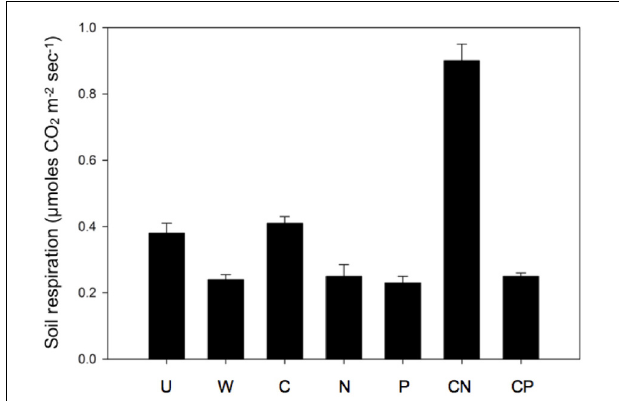
FIGURE 5 | Soil respiration dramatically increased following CN additions. Values are means ± SEM ( n = 8) with letters indicating differences ( P < 0.05) based on a one-way ANOVA and Tukey’s HSD